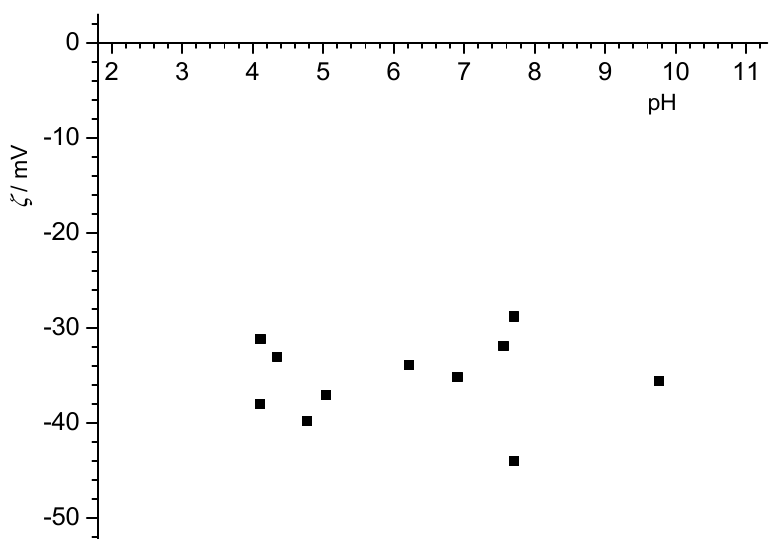
Figure 5. Electrokinetic zeta-potential of PTFE-B-200 in aqueous sodium chloride solution I c = 1 mmol dm − 3 , θ = 25 °C.